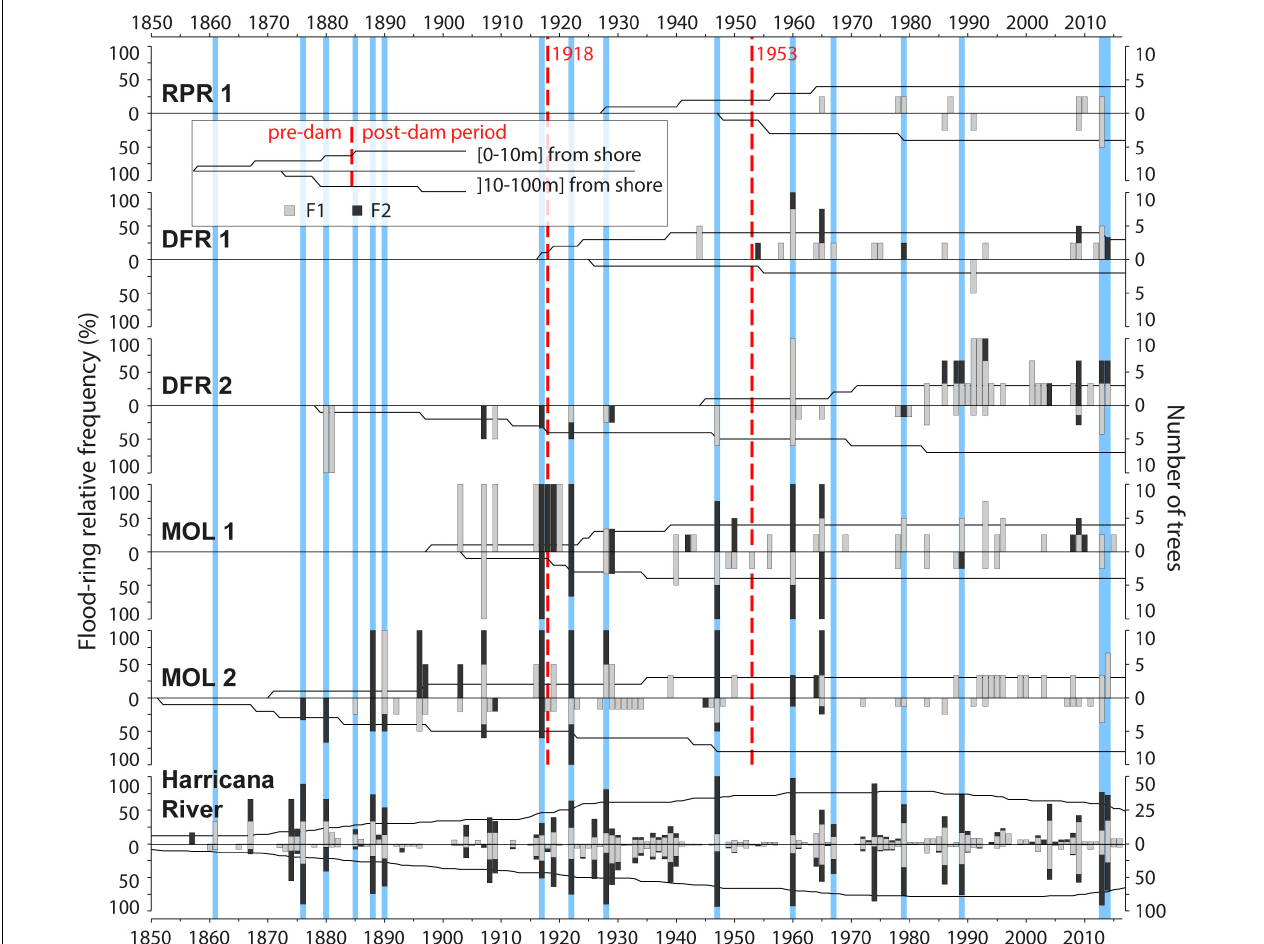
FIGURE 4 | Flood-ring chronologies for each of the five sites and organized by distance classes to the shoreline (0–10 and 10–100 m) and for the naturally flowing Harricana River. Trees close to the shoreline (0–10 m) are shown with positive bars and trees from the floodplain (10–100 m) with negative bars. Gray and black histograms are, respectively, F1 and F2 flood-ring relative frequencies, and the black solid line in the background indicates temporal replication among the trees sampled per year. Vertical red dashed lines indicate dates of construction of the first and second Monteith dam. Blue vertical bars indicate the years with the highest reconstructed spring discharge for the Harricana River (threshold value = 151.3 m 3 /s; Nolin et al.,